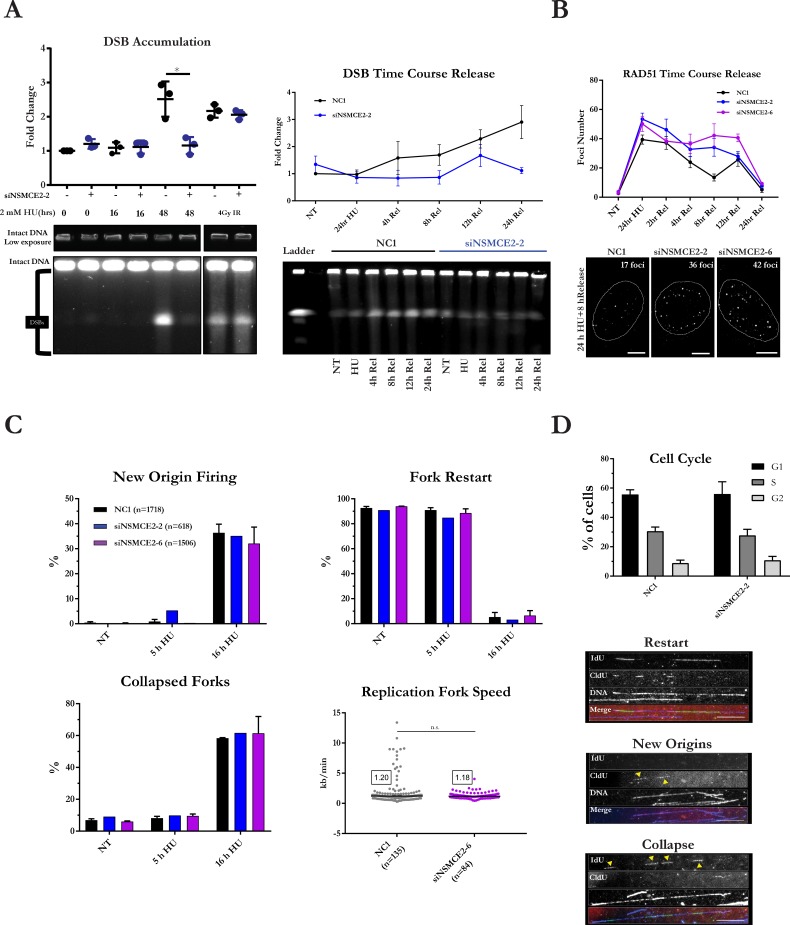
DSB formation and resolution of RAD51 foci at collapsed forks is dependent on NSMCE2.(A) Cleavage of collapsed forks is dependent on NSMCE2. Quantitative analysis (top panel on left) and representative image (bottom panel on left) of DSBs in control and NSMCE2-deficient HeLa cells treated or not with HU for 24 hours then released for 16 or 48 hours. As a control, cells were irradiated with 4 Gy and allowed to recover for 30 min. DSBs were visualized by PFGE. Three independent experiments were performed. (top panel on right) Quantitative analysis of DSBs at different times after release from HU block. Mean and standard deviation is shown. Different time courses were performed, including release times of 4 hours and 8 hours; 12 hours and 24 hours; and 4 hours, 8 hours, 12 hours, and 24 hours. In each time course, the no-treatment sample was used to normalize the data. A minimum of two independent experiments were analyzed for the 4-hour and 8-hour and the 12-hour and 24-hour time courses. (bottom panel on right) Image of a representative PFGE experiment. (B) Persistence of RAD51 foci after release from HU block in NSMCE2-deficient cells. (top panel) Quantitative analysis of number of RAD51 foci per cell at different times after release from HU block. Mean and standard error are shown. At least 10,000 RAD51 foci were analyzed in each experimental condition. Three independent experiments were performed. (bottom panel) Three representative images from the experiment. Scale bars represent 10 microns. (C) Similar replication dynamics in normal and NSMCE2-deficient cells treated with HU. DNA combing analysis by maRTA of HeLa cells exposed to control and NSMCE2 siRNAs and treated or not with 2 mM HU for 5 hours or 16 hours. Two independent experiments were performed. Four panels show quantitative analysis of new origin firing, replication fork re-start, fork collapse, and replication fork speed. The three panels below the bar graph in (D) show representative images from the maRTA. (D) Cell-cycle analysis by flow cytometry of untreated HeLa cells pulsed with 20 μM BrdU for 40 min. Mean and standard deviation is shown. Three independent experiments were performed.